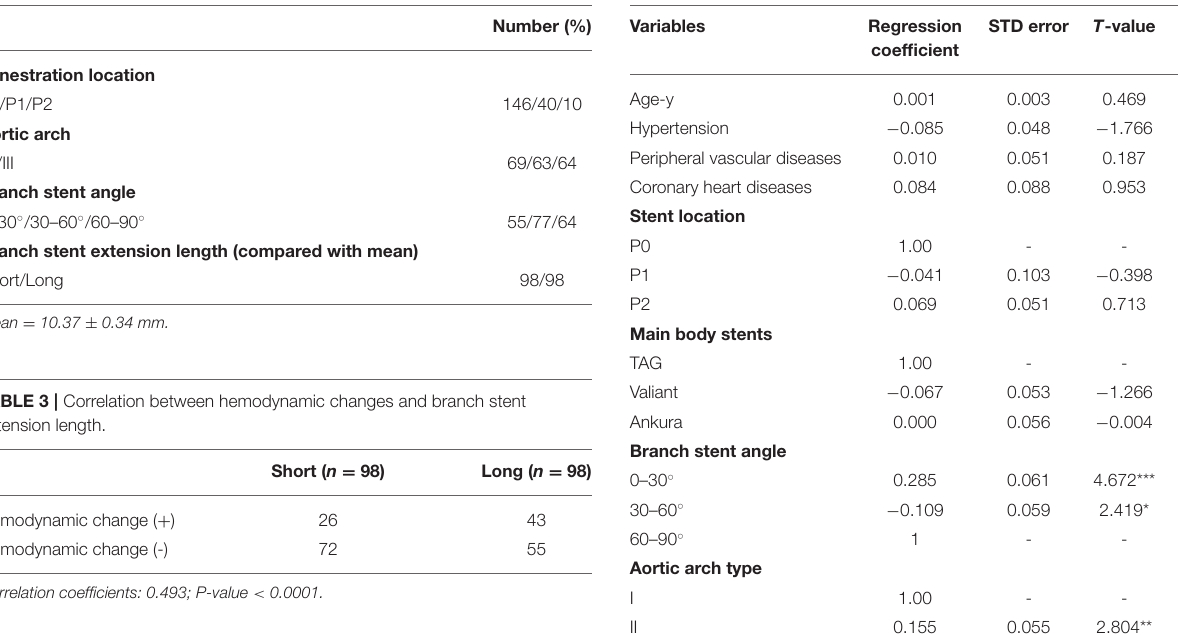
TABLE 4 | Linear regression analysis of interference factors for branch stent extension